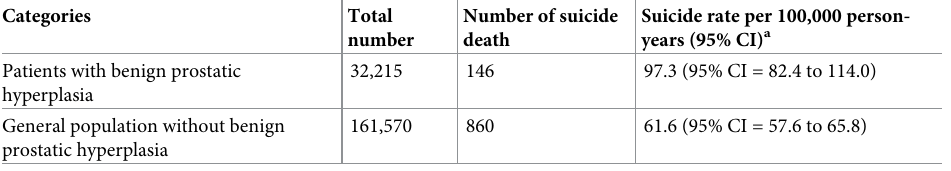
Table 2. Number of suicide death and suicide rates in patients diagnosed with benign prostatic hyperplasia and general population without benign prostatic